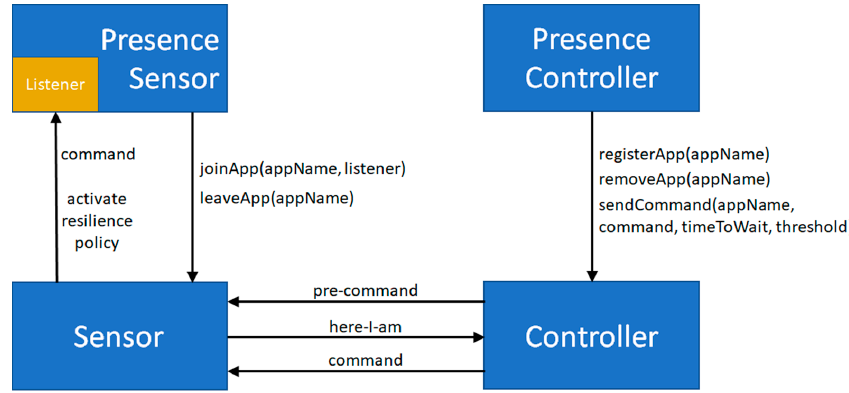
Figure 4. Presence and Controller components.